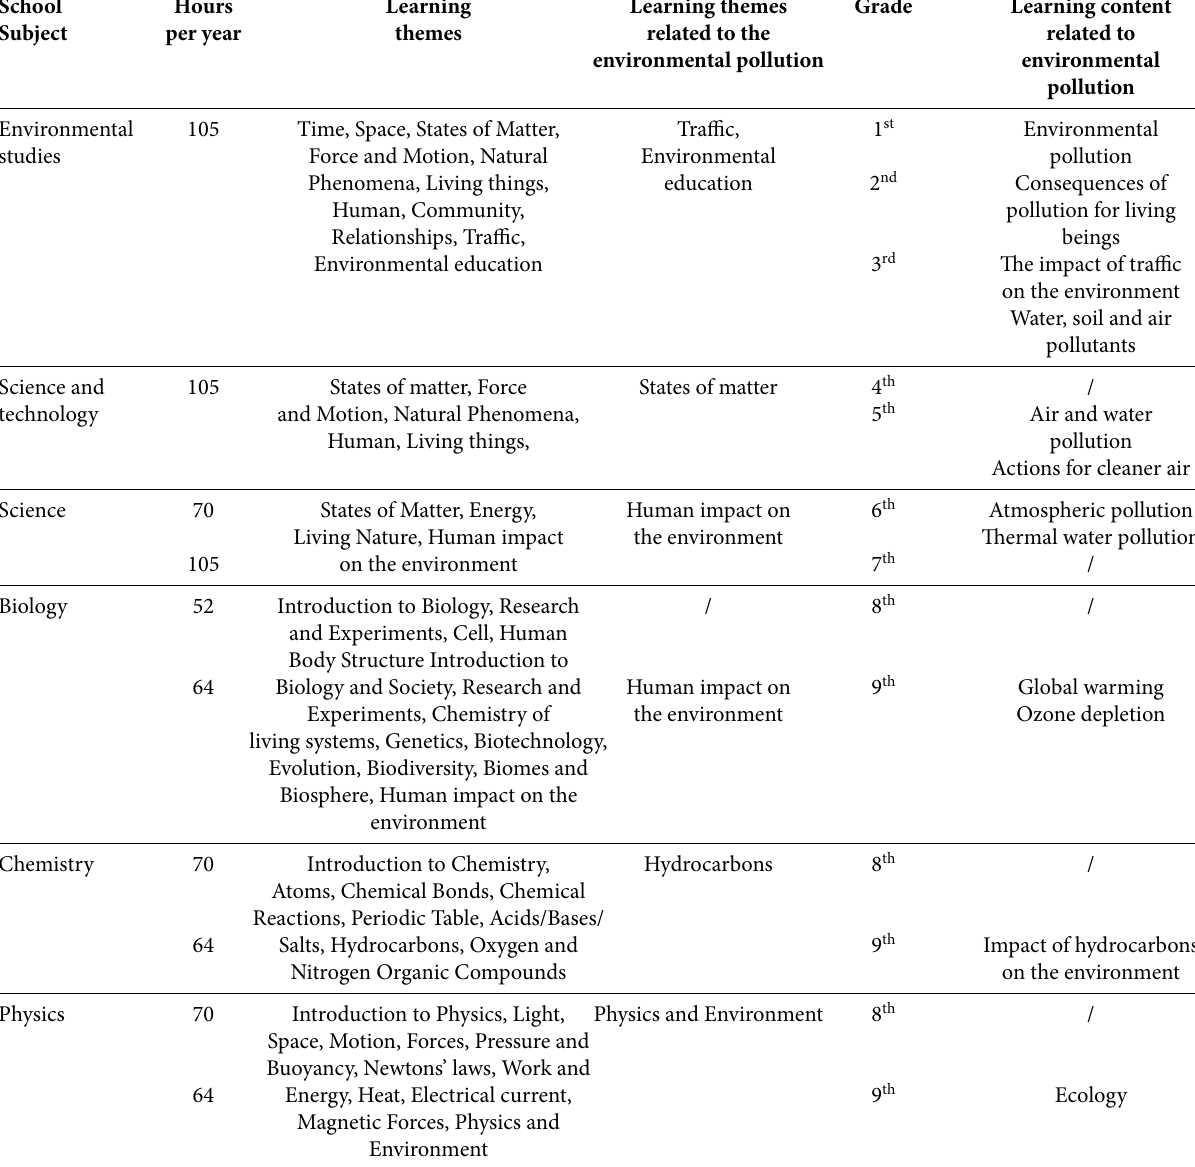
Table 2. Curricula analysis of subjects in compulsory education in Slovenia and learning content connected with the environmental pollution